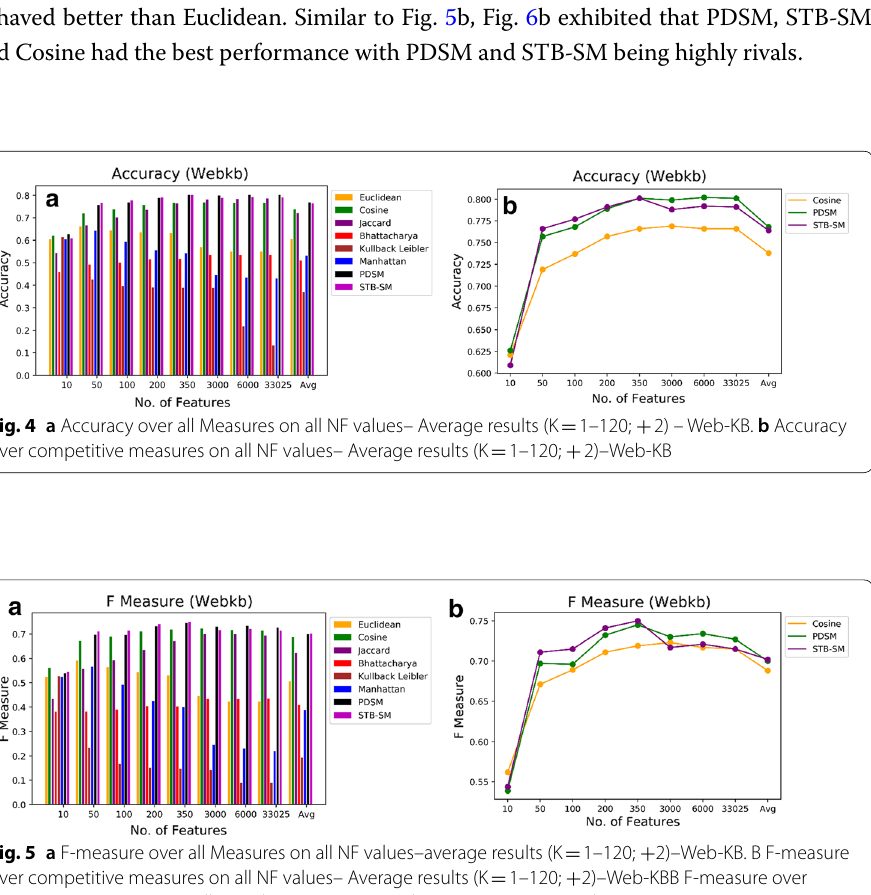
1–120; 2)–Web-KB. B F-measure = + 1–120; 2)–Web-KBB F-measure over = + 1–120; = +